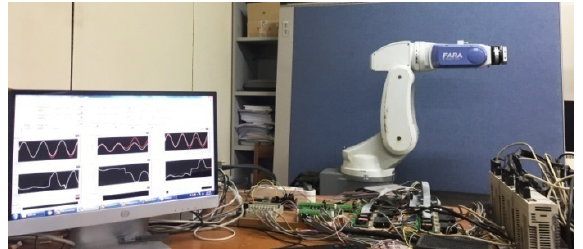
Figure 9. The experimental setup with FARA-AT2 Robot